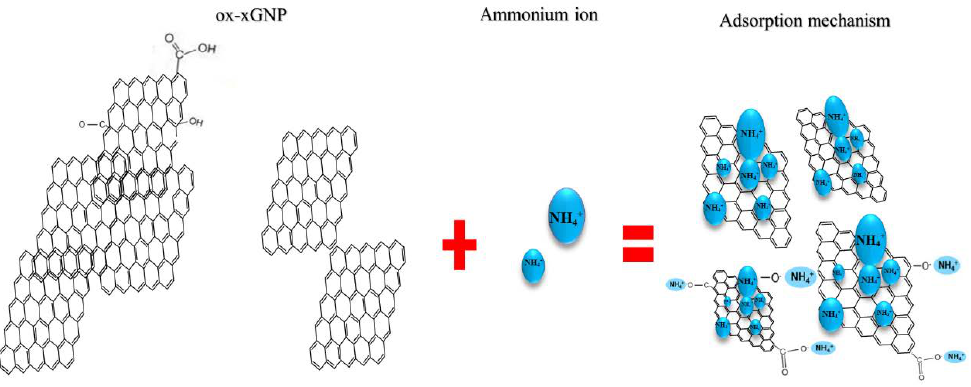
Figure 10. The adsorption mechanism of ammonium ions on